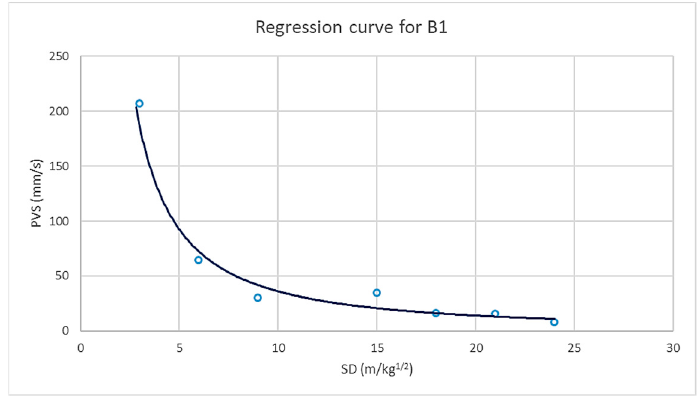
Figure 2. Regression curve for data from borehole B1.